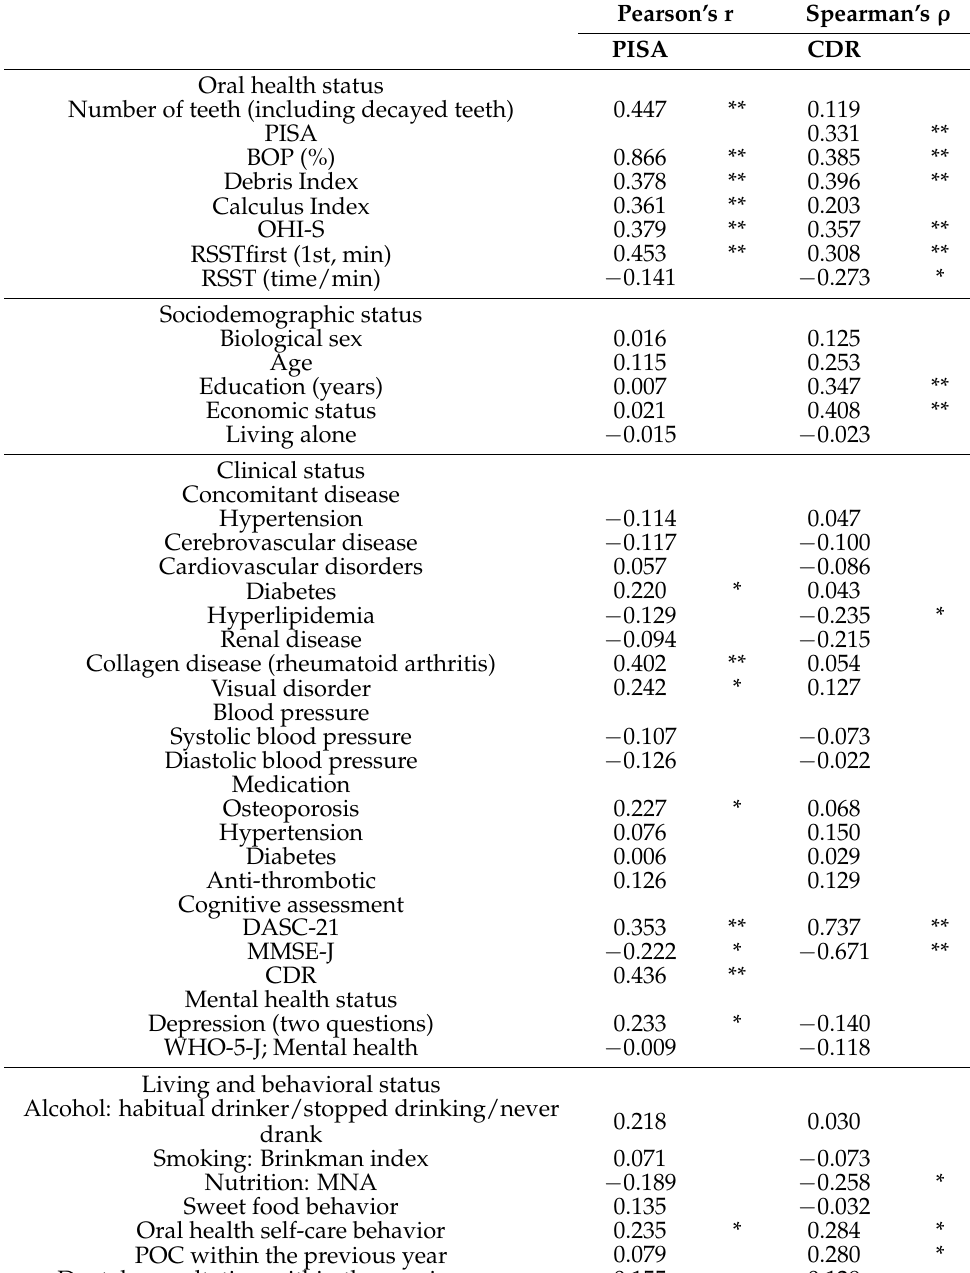
Table 2. The correlation of factors associated with PISA and